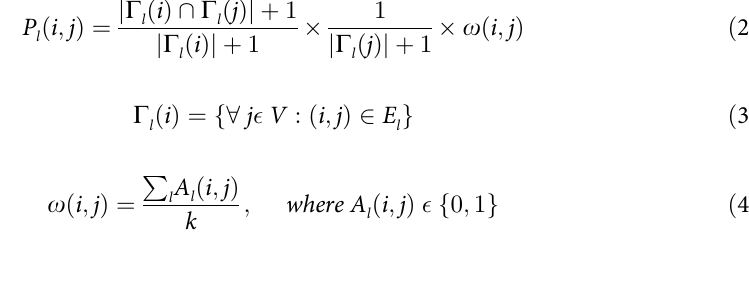
stands for the adjacency matrix l